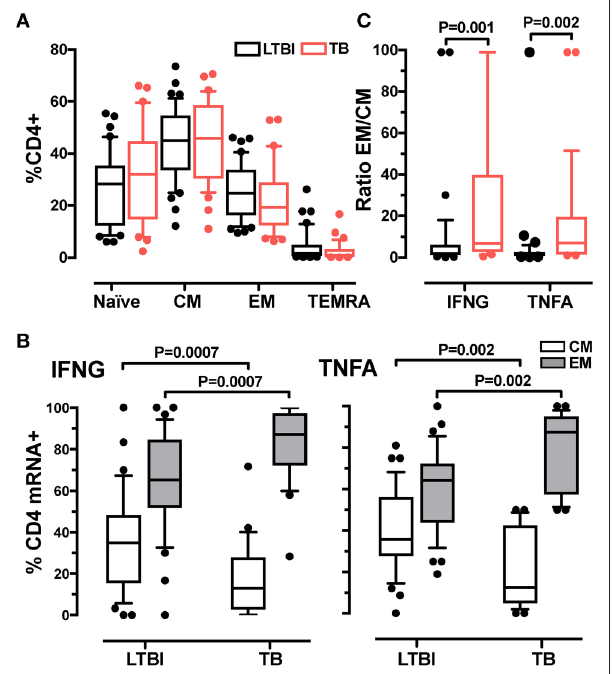
FIGURE 2 | Analysis of memory CD4 + T cell subsets in LTBI and active TB donors. (A) Frequencies of CD4 + T cell subsets in LTBI and active TB